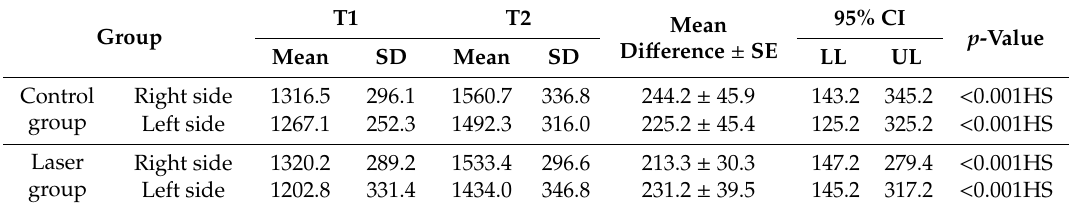
Table 2. Comparison of condylar volume (mm 3 ) before and after twin block therapy within each group using paired t -test.